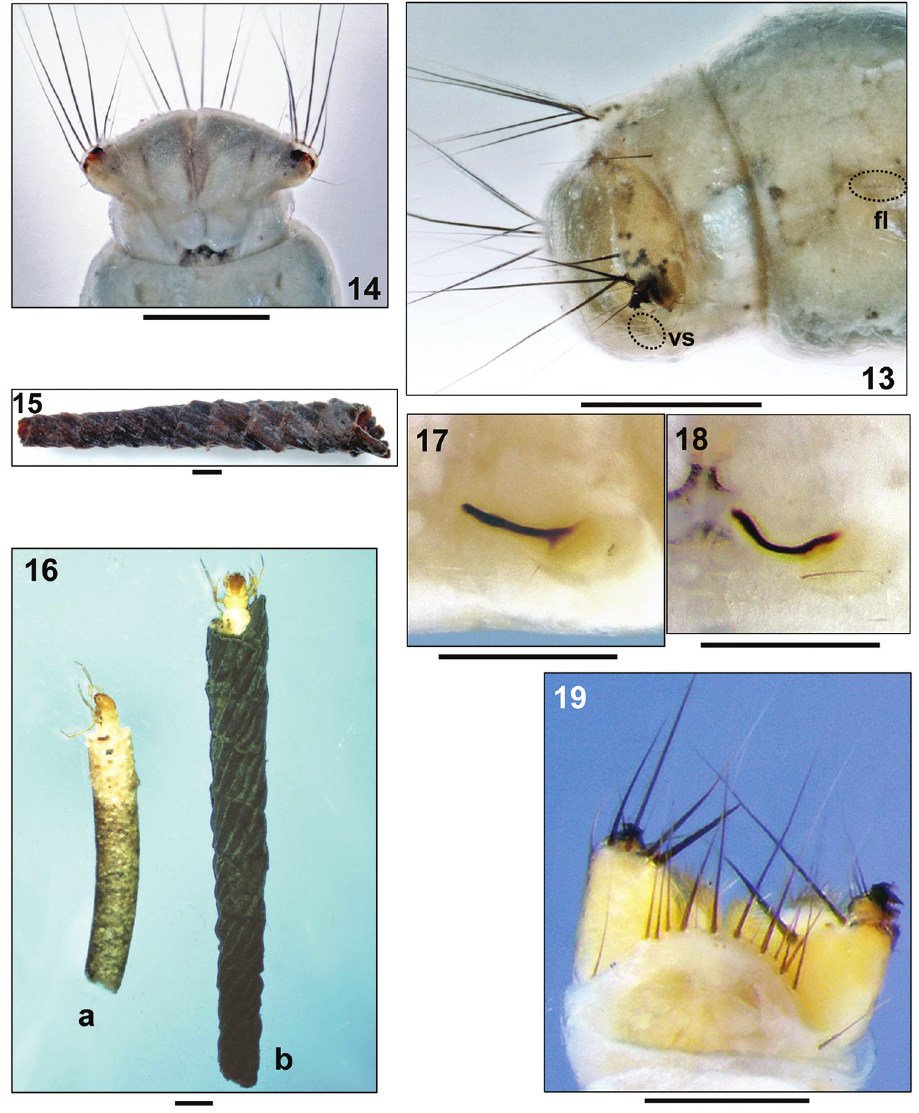
Figures 13–19. 13–15 Adicella syriaca Ulmer, 1907, final instar larva: 13 Tip of abdomen, right lat- eral (fl= forked lamellae on segment VIII; vs= ventral setae on segment IX) 14 Tip of abdomen, ventral 15 Larval case, right lateral 16 Final instar larvae in their cases. a Adicella filicornis (Pictet, 1834) b Adicella reducta (McLachlan, 1865) 17–18 Lateral sclerites on abdominal segment I of fifth instar larvae, right lateral view: 17 Adicella reducta (McLachlan, 1865) 18 Adicella cremisa Malicky, 1972 19 Adicella filicornis (Pictet, 1834), final instar larva. Tip of abdomen, dorsal. Scale bars: 0.5 mm (except Figs 15, 17: 1